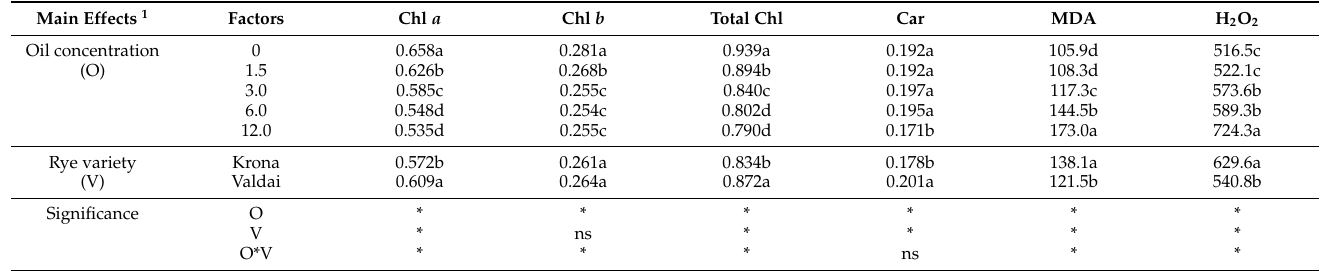
Table A1. Results of two-way ANOVA for photosynthetic pigments and oxidative stress parameters.